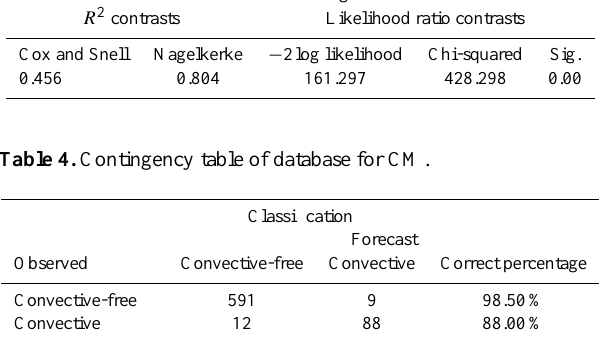
Table 2. Parameters selected by logistic regression for CM: metric explanatory variables input to the model, β coefficients used to ex- tract the sign, and Wald parameter used to compute the weight. The symbol “ · ” represents multiplication between variables.